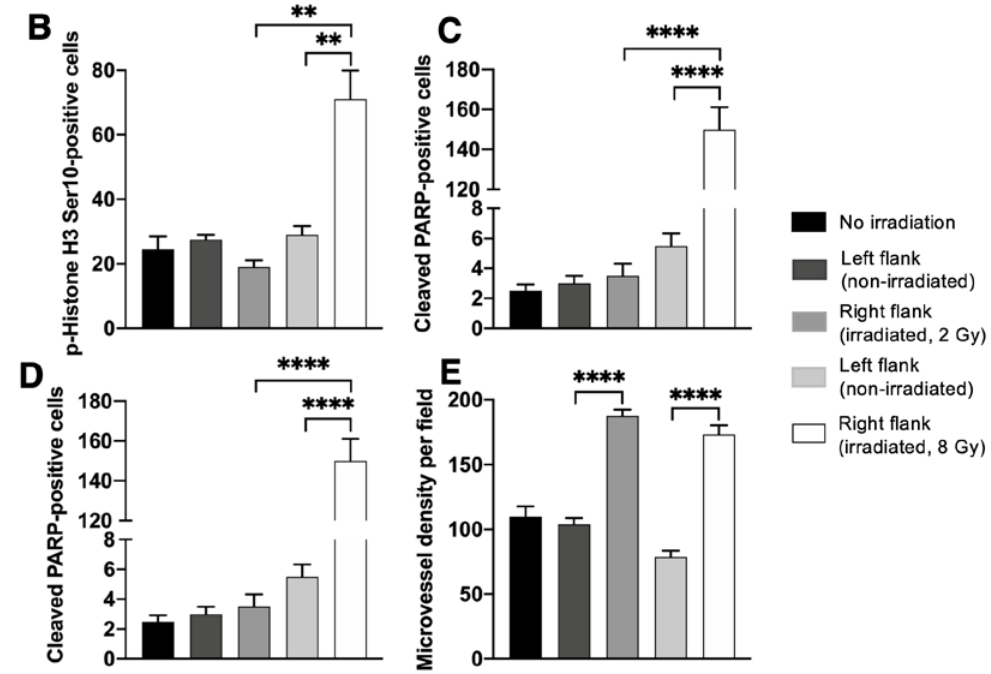
Figure 2. Effects of localized radiotherapy on angiogenesis, cell proliferation, apoptosis, and blood vessels in HCC19-0913 tumors. HCC19-0913 tumors were implanted on both flanks, and tumors on the right flank were irradiated with either 2 or 8 Gy. Tumor tissues were collected 2 days post-irradiation and subjected to immunohistochemistry. Representative images of tumor sections from control non-irradiated mice, internal control (left flanks), and irradiated tumors (right flanks) were stained for blood vessels (CD31), p-Histone H3 Ser 10, cleaved PARP, γ H2AX, and Hypoxyprobe as described in Appendix A ( A ). The number of staining-positive cells among at least 500 cells per region was counted and is expressed as the number of positive cells per 1000 cells ± SE ( B – D ). For the quantification of mean microvessel density, five random fields at a magnification of × 100 were selected for each section. The number of CD31-positive blood vessels per field was counted as described in Appendix A and presented as mean ± SE ( E ). ** p < 0.01; **** p < 0.0001, Student’s t -test.